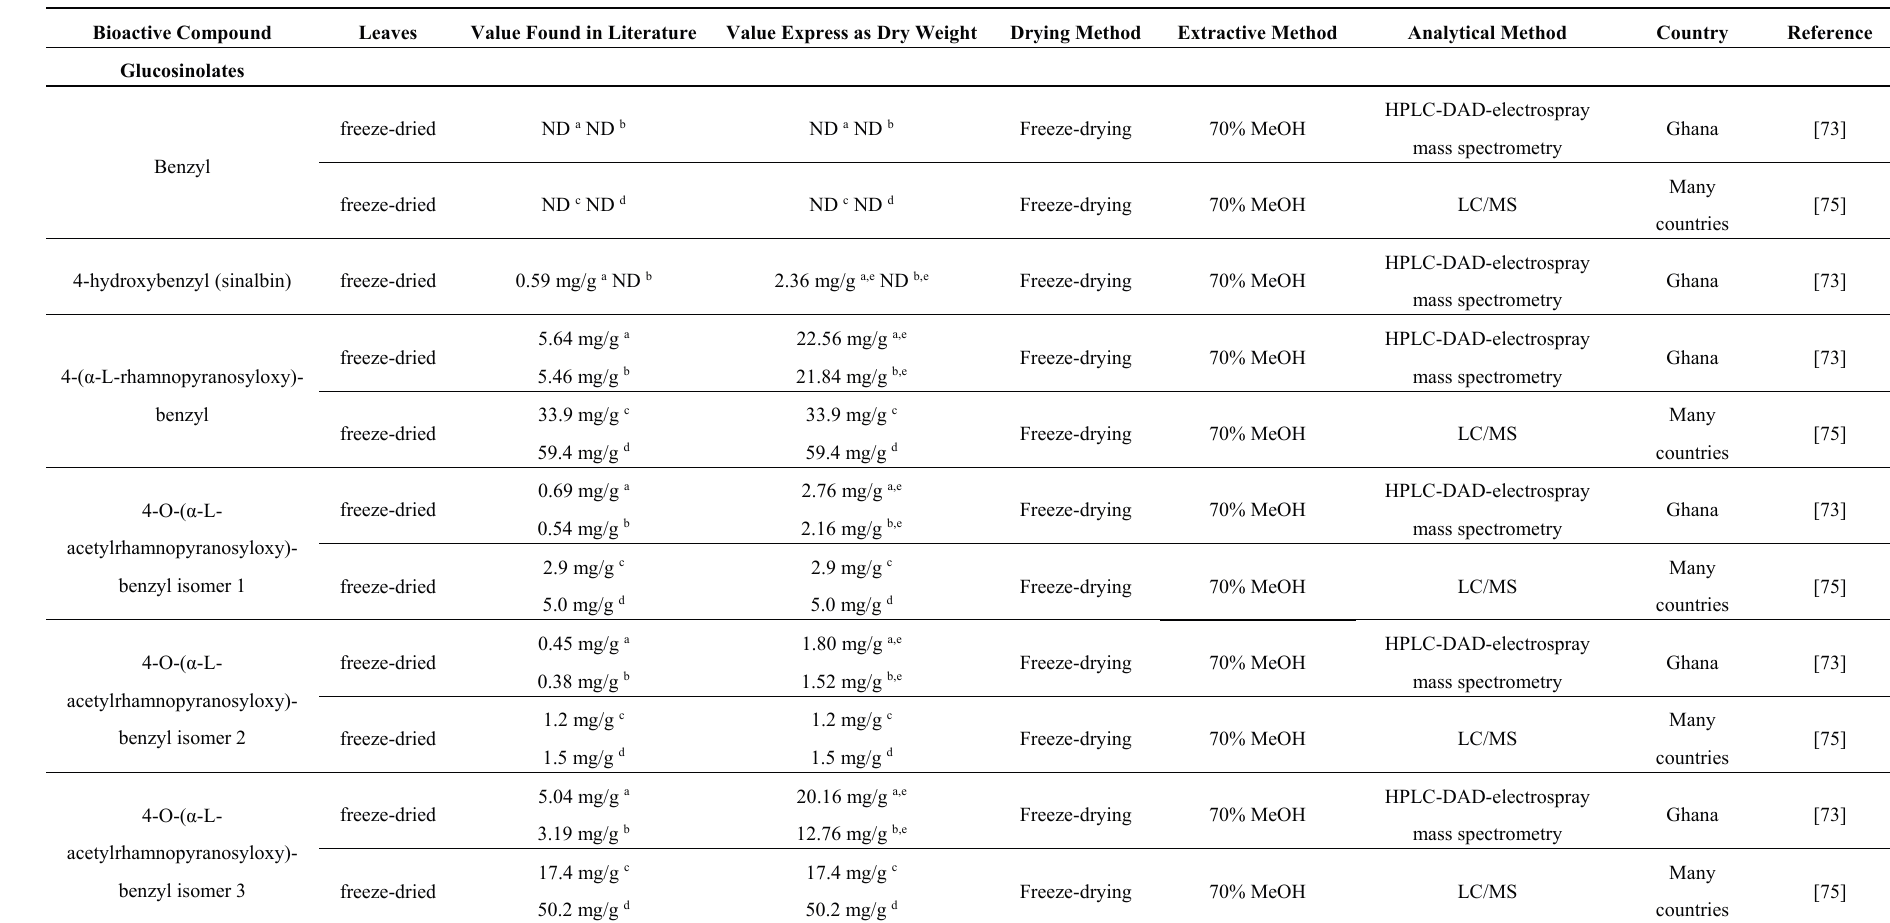
Table 6. Glucosinolates content in Moringa oleifera